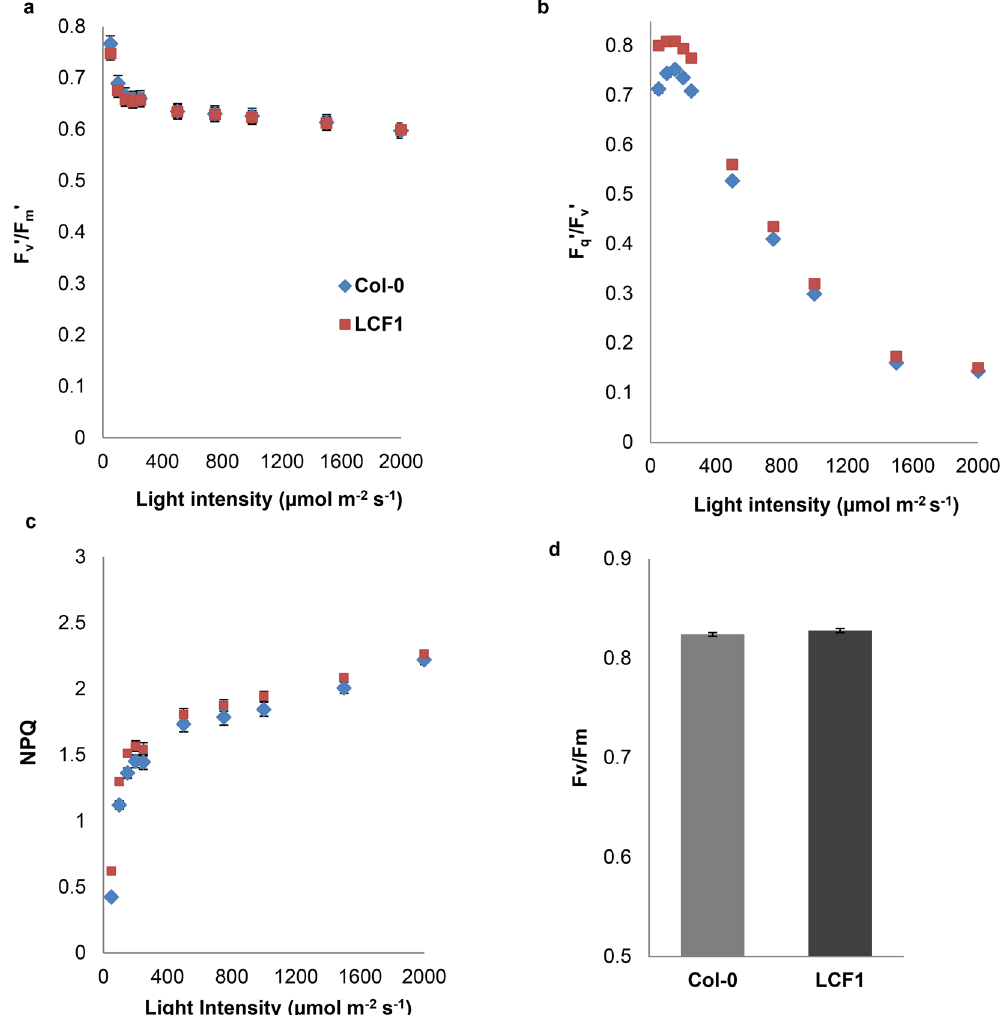
Figure 4. Quantification of ( a ) the maximum efficiency of Photosystem II in the light (F v ′ /F m ′ ), ( b ) the coefficient of photochemical quenching (F q ′ /F v ′ ) and ( c ) NPQ of Col-0 and LCF1 plants at different light intensities (19 days after germination). Response curves were made by adapting the plants to every actinic light intensity for 30 s, followed by a saturating pulse. ( d ) Quantification of the maximum quantum efficiency of PSII photochemistry (F v /F m ) of dark- adapted Col-0 and LCF1 plants (19 days after germination). Error bars represent SEM values (n = 12 per genotype) and are visible only when exceeding the data